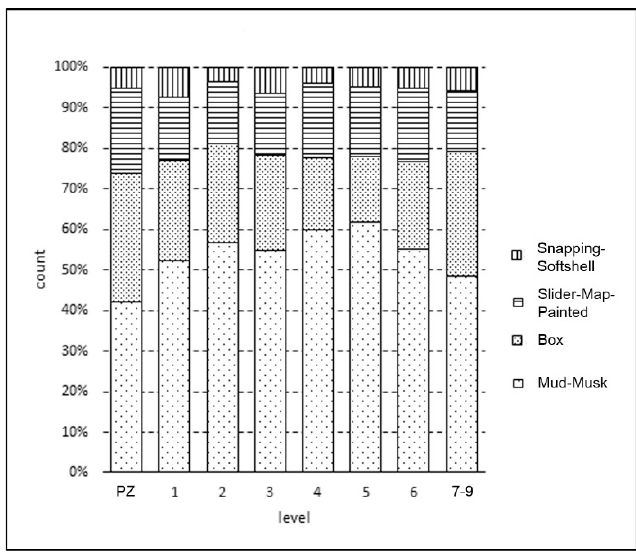
Figure 4. Turtle taxon counts by level.